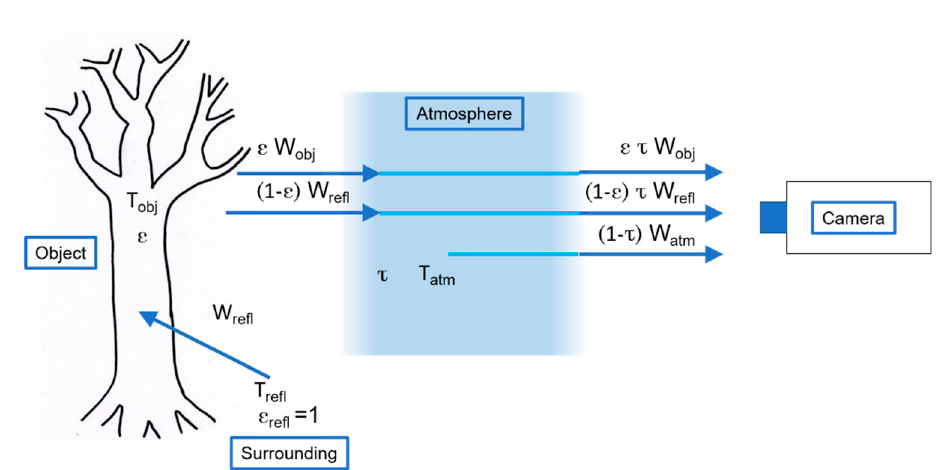
Figure 1. A schematic representation of infrared thermography (IRT) basics (adapted from [19]).